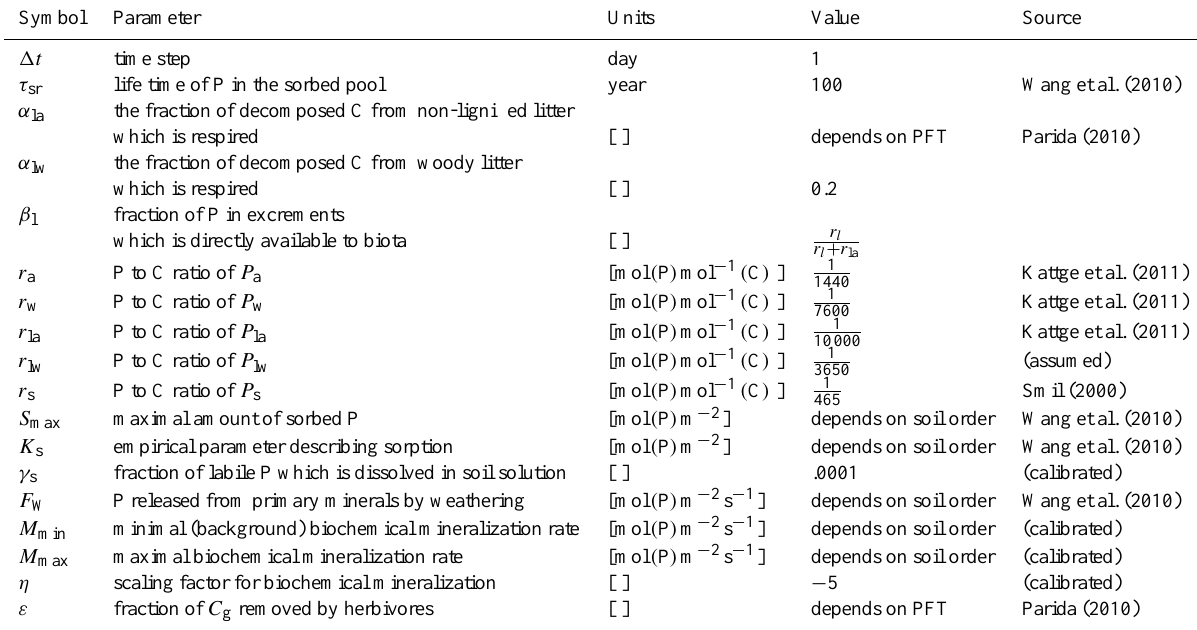
Table 2. Parameters of the P model. The soil order specific values of parameters are listed in the Appendix E. In the case of Kattge et al. (2011), plant trait data have been made available via the TRY database. These data are related to the following original references: Bakker et al. (2005, 2006); Baker et al. (2009); Cornelissen (1996); Cornelissen et al. (1996, 2003, 2004); Craine et al. (2005, 2009); Diaz et al. (2004); Fortunel et al. (2009); Fyllas et al. (2009); Garnier et al. (2007); Han et al. (2005); He et al. (2006, 2008); Kazakou et al. (2006); Laughlin et al. (2010); Meziane and Shipley (1999); Niinemets (1999, 2001); Ogaya and Penuelas (2003, 2006, 2007, 2008); Ordonez et al. (2010b,a); Pati˜no et al. (2009); Pakeman et al. (2008, 2009); Quested et al. (2003); Reich et al. (2008); Sardans et al. (2008a,b); Shipley